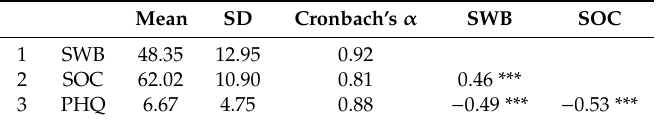
Table 2. The descriptive statistics reliabilities and Pearson’s correlation of SWB, SOC, and PHQ. Mean SD